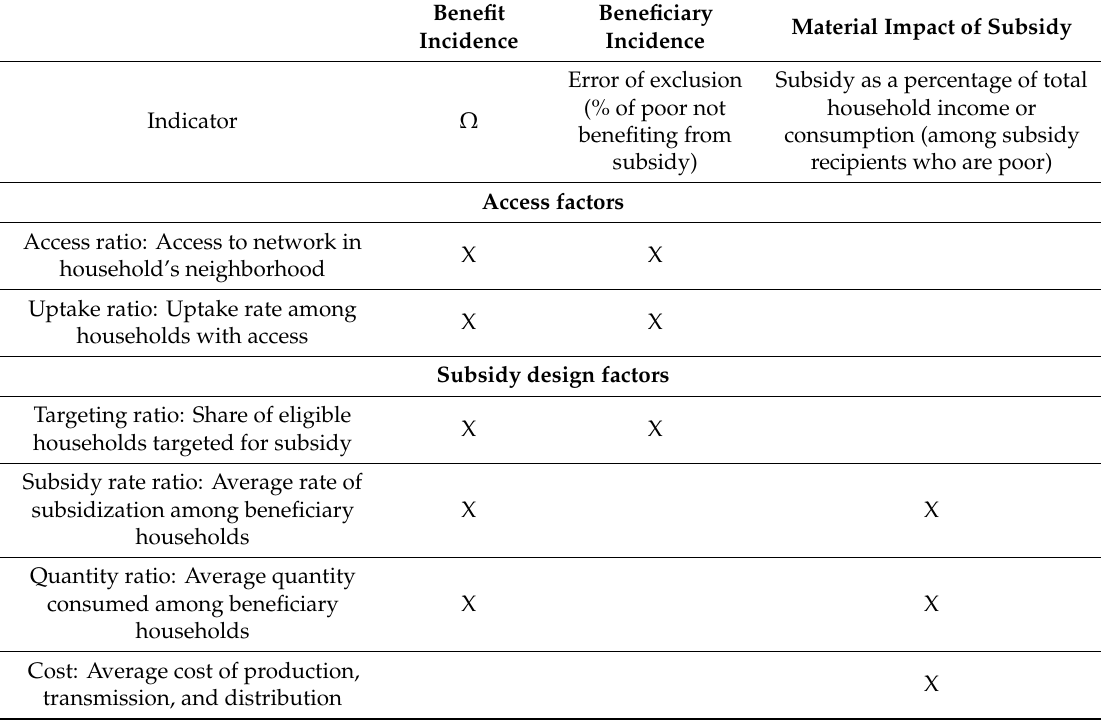
Table 9. Determinants of consumption subsidy